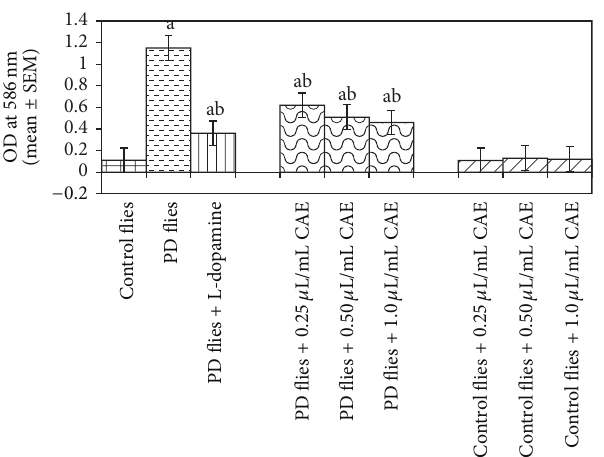
Figure 15: Effect of Centella asiatica extract (CAE) on protein carbonyl content measured in the brains of transgenic Drosophila melanogaster after 24 days of the exposure to various treated groups ( a significant with respect to control, 𝑃 -0.01; b significant with respect to PD model flies, 𝑃 -0.05). L-Dopa = 10 −3 M; control flies: UAS- alpha-syn; PD flies: elav-GAL4;